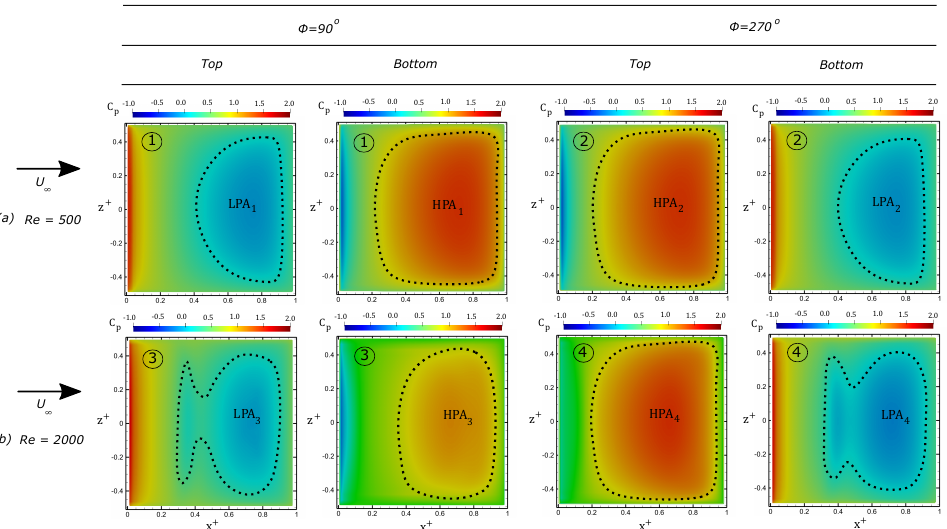
Figure 12. Surface pressure contours of C p , plotted on top and bottom surface of square panel for ( a ) Case 6, and ( b ) Case 7, respectively, at positions of peak trailing edge amplitudes (i.e., φ = 90 ◦ and 270 ◦